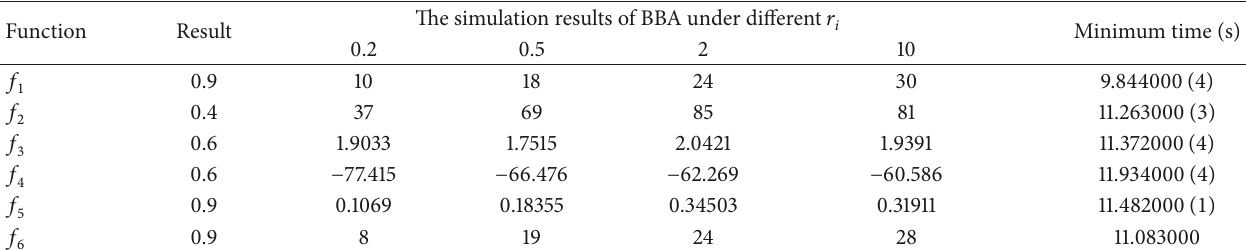
Table 3: Performance comparison of BBA under different 𝑟 𝑖 .